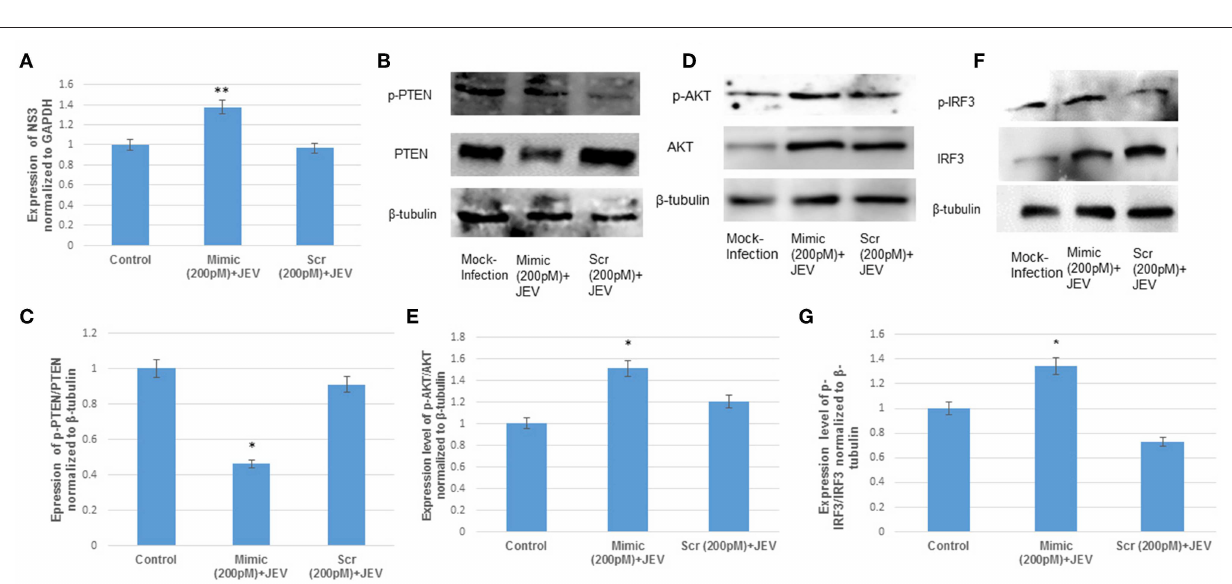
the induction of type-I interferon via IRF3 activation (Manocha et al., 2014). A similar response has been shown by PTEN during JEV infection, where the suppression of PTEN resulted